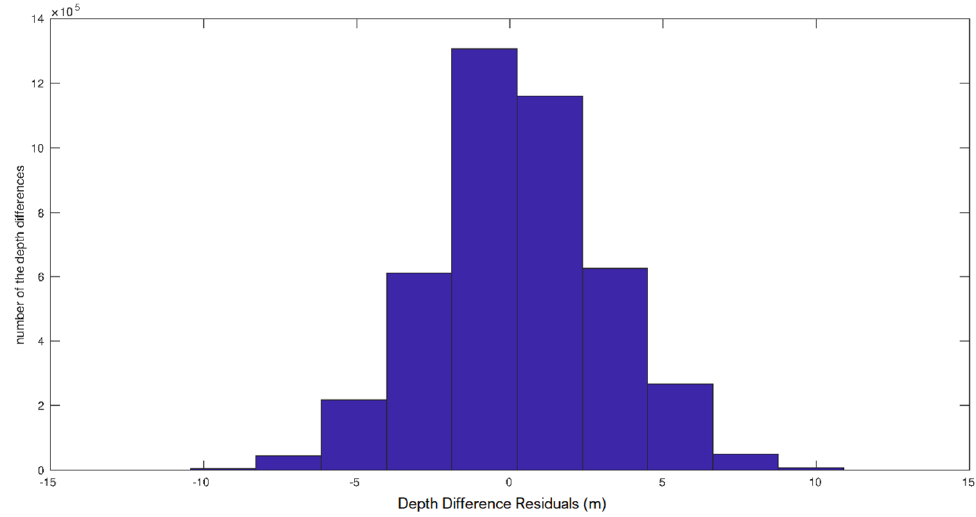
Figure 18. The histogram of the relative residuals calculated based on the 2nd order surface fit.